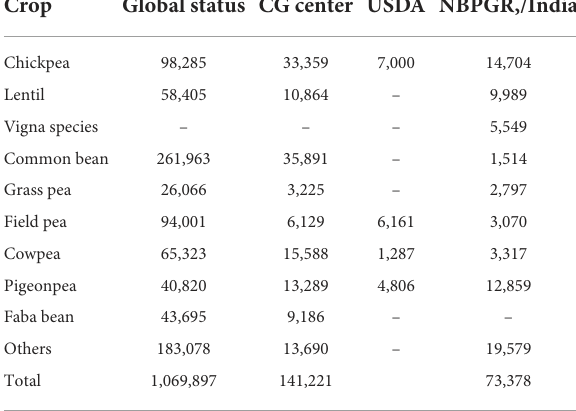
TABLE 2 Legume germplasm holdings in major gene